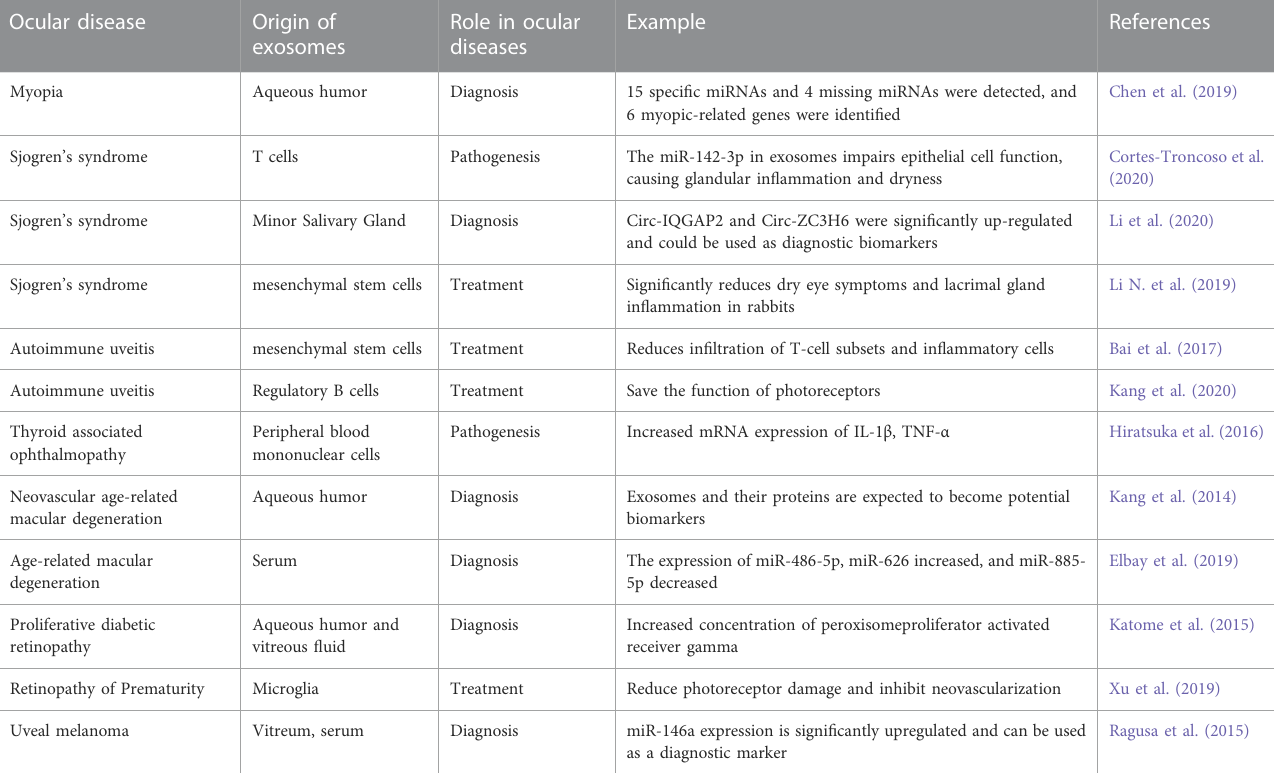
TABLE 2 The role of exosomes in other ocular diseases. Ocular